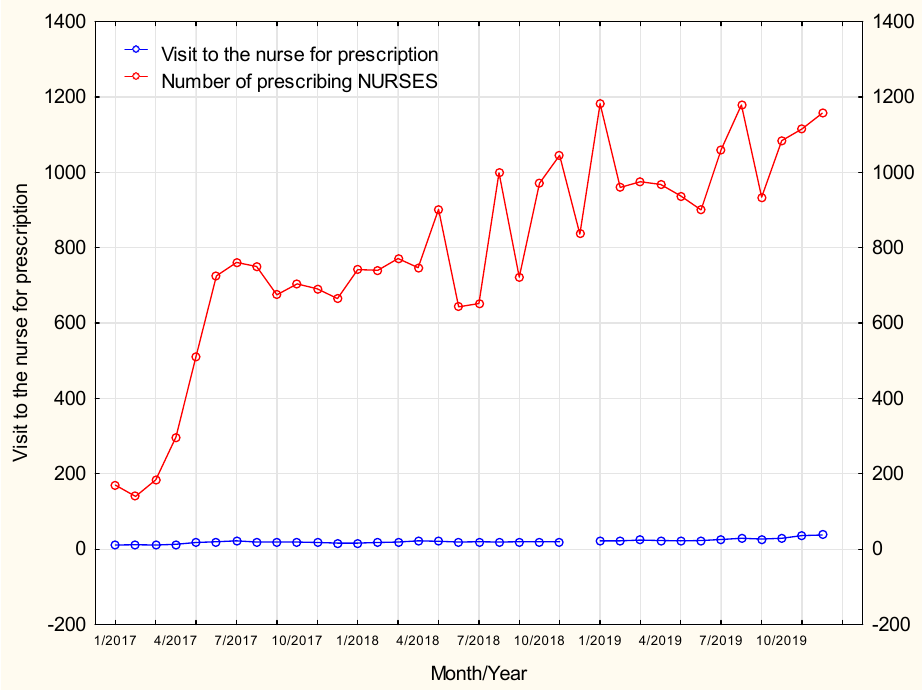
Figure 8. The number of licensed nurses and the number of patients’ visits.